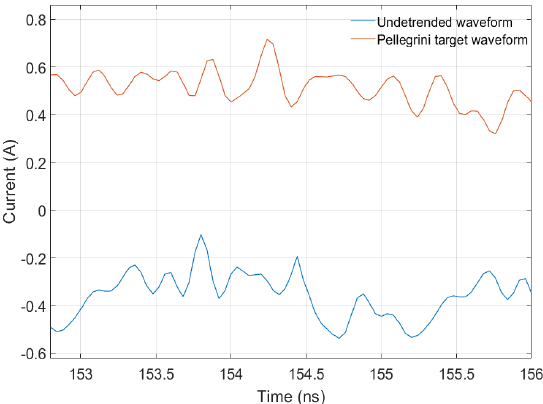
Figure 8. Comparison of the current values of the undetrended waveform with the reference waveform for the last 80 measurement points.